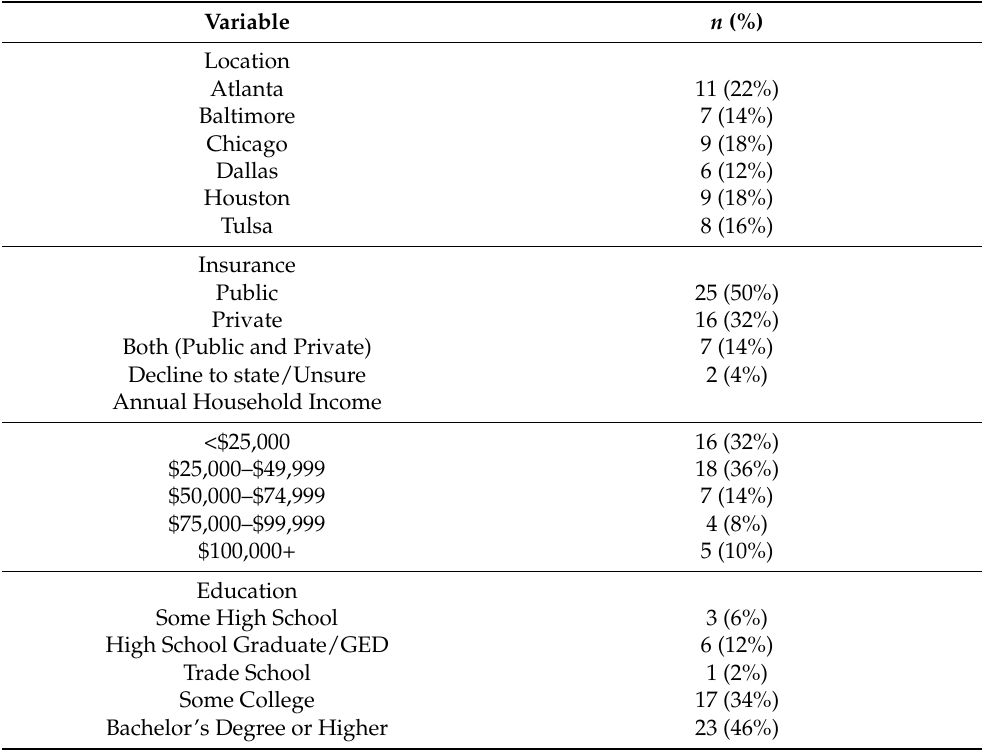
Table 1. Participant Demographics and